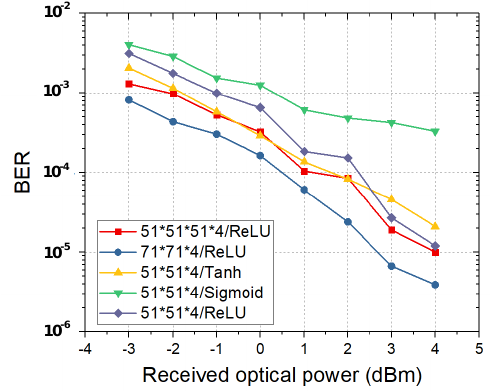
Figure 3. ( a ) BER versus memory length of first-order VE with received optical power of 1 dBm and 0 dBm (B2B) and 0 dBm (100 m); ( b ) BER versus input symbol number with 51 hidden neurons and three layers and received optical power of 1 dBm.